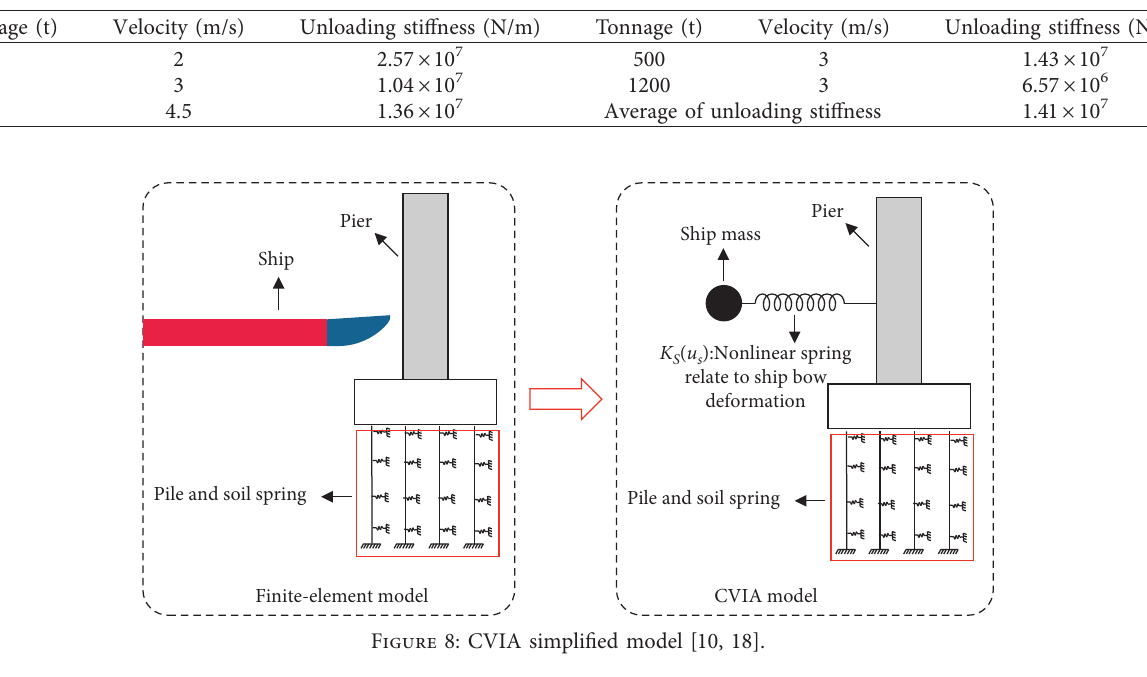
Table 5: Unloading stiffness.